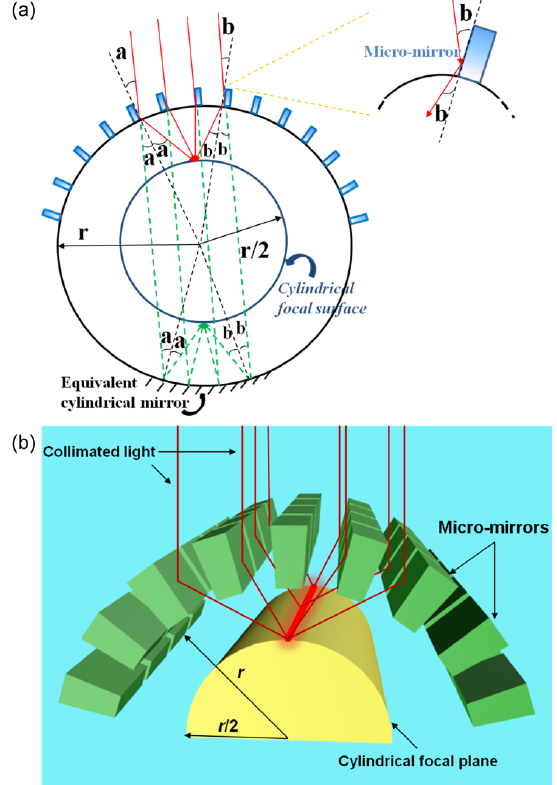
Figure 1. ( a ) Schematic representing the operating principle of our device with radius of curvature r under collimated illumination. The way the incoming light is reflected by an array of micro-mirrors is equivalent to that by a mirrored cylindrical surface with the same radius r (see both half of the circle). Due to the spherical symmetry, both have a same cylindrical focal plane with radius of curvature of r /2; ( b ) An equivalent, 3-D representation of ( a ) to demonstrate the 1-D focusing and beam shaping mechanism of our